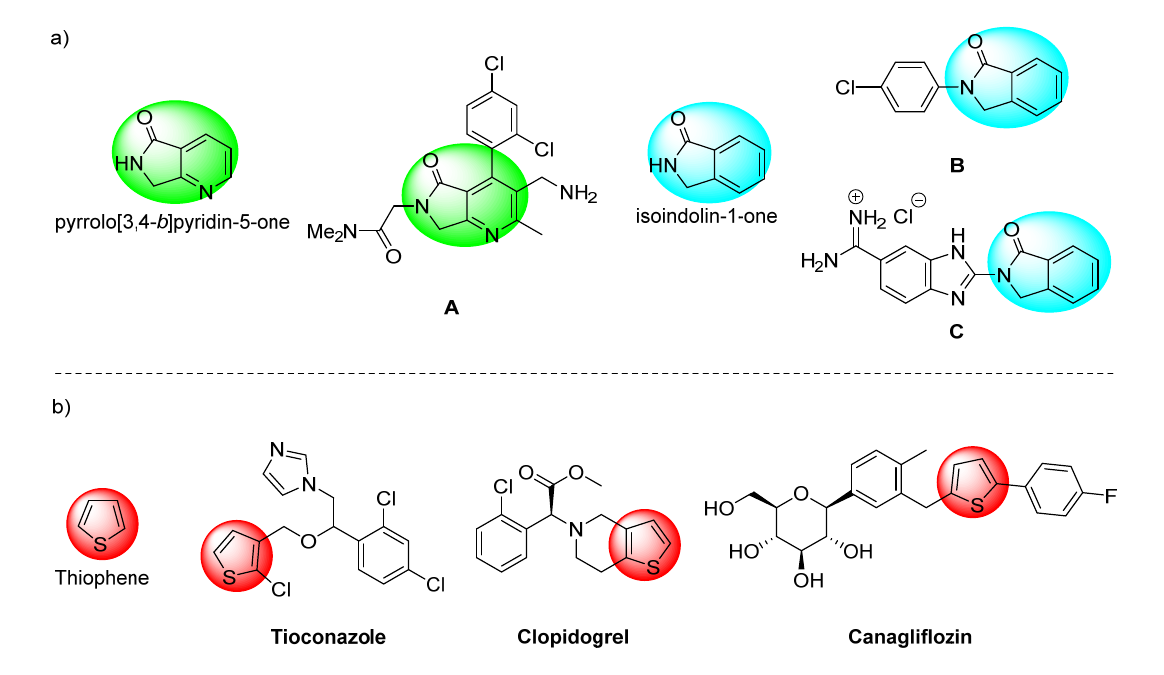
Figure 1. ( a ) a fused-pyrrolo[3,4- b ]pyridin-5-one and isoindolin-2-ones of interest in medicinal chemistry, ( b ) thiophene-based current drugs.